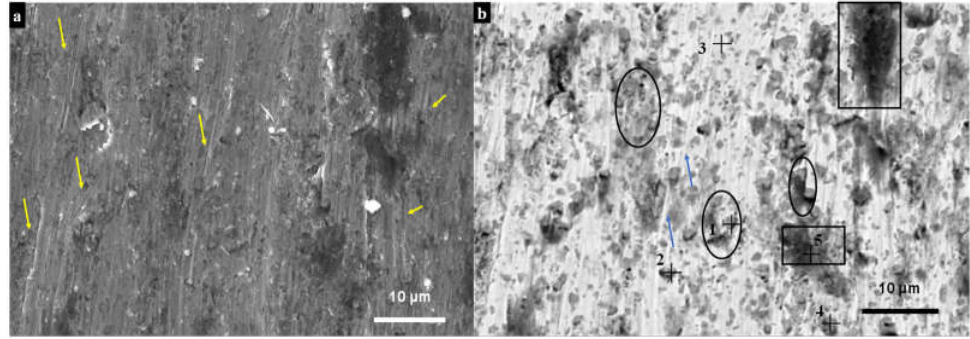
Figure 11. SEI ( a ) and BSE ( b ) SEM of Fe-Cr-C-V coating (25.4 mm) tested with #50 sand and 48 N load. Table 7. EDS results of Fe-Cr-C-V coating (25.4 mm) tested with #50 sand and 48 N. Point